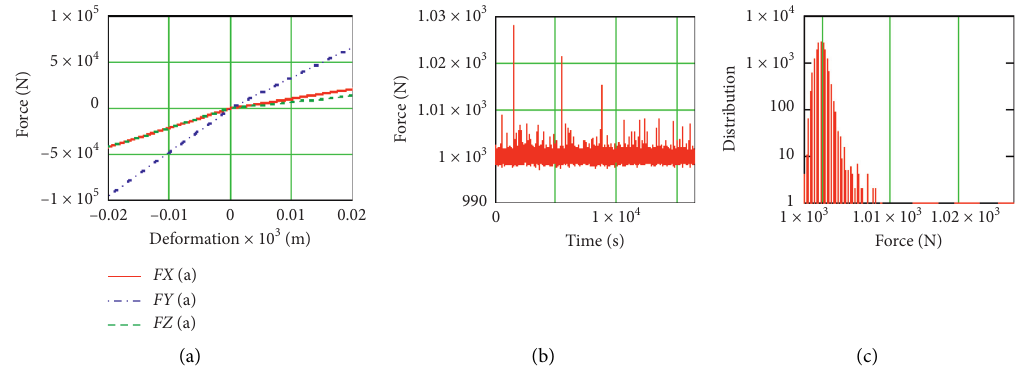
Figure 6: Bilinear stiffness of springs (a); stochastic force in the time domain (b); and force distribution (c).